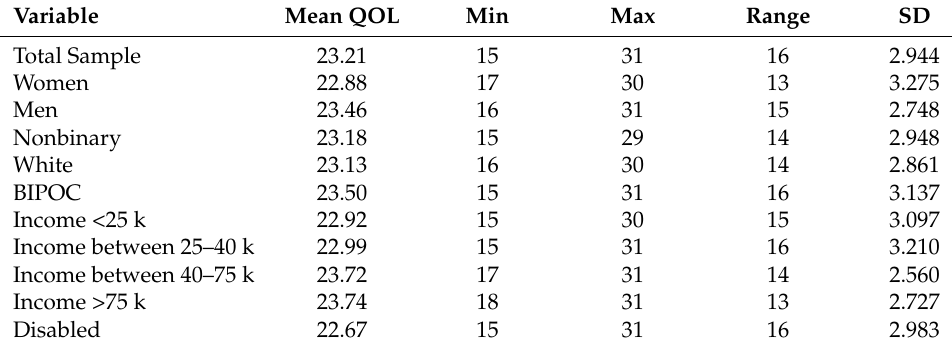
Table 2. QOL descriptive